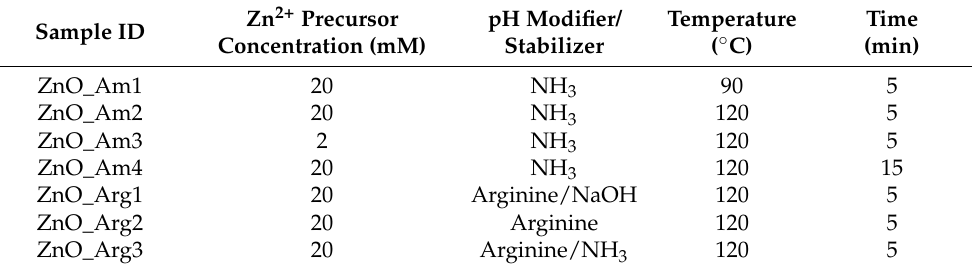
Table 1. ZnO NPs synthesized under various